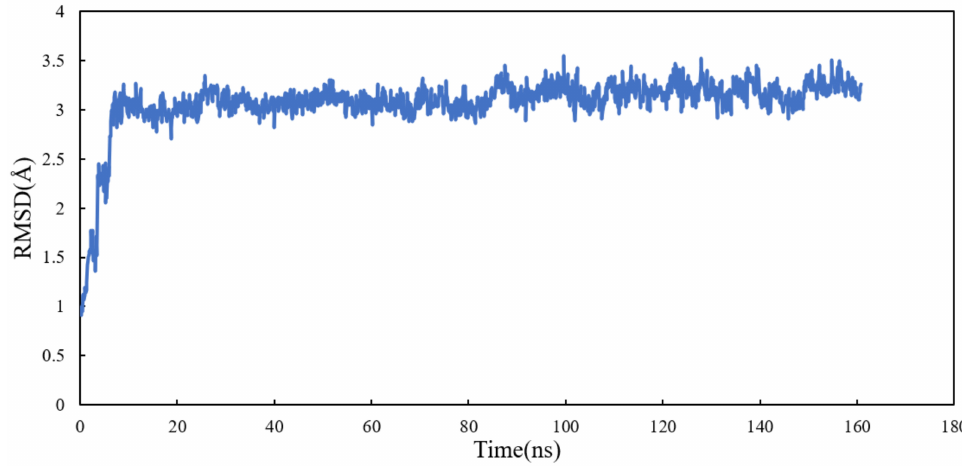
Figure 12. RMSD plot of scoulerine docked to the laulimalide binding